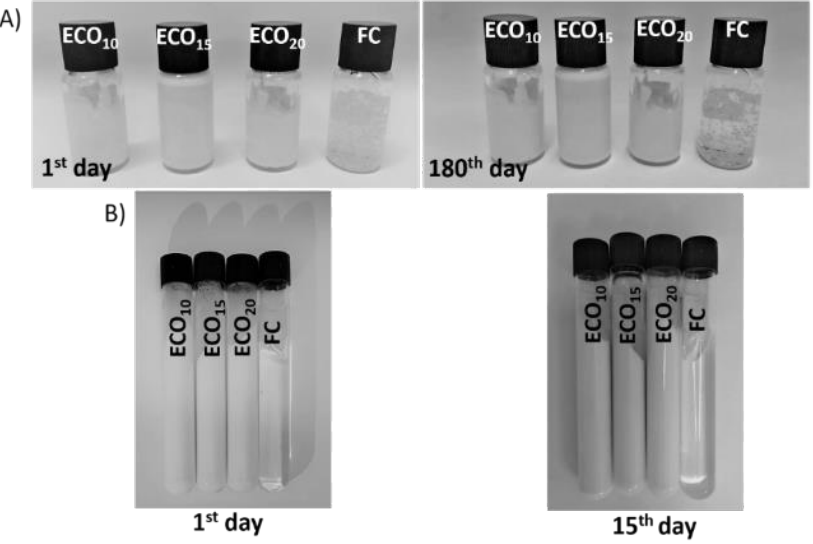
Figure 2. Stability of formulations: ( A ) shelf test; ( B ) cosmetic stability guide studies.